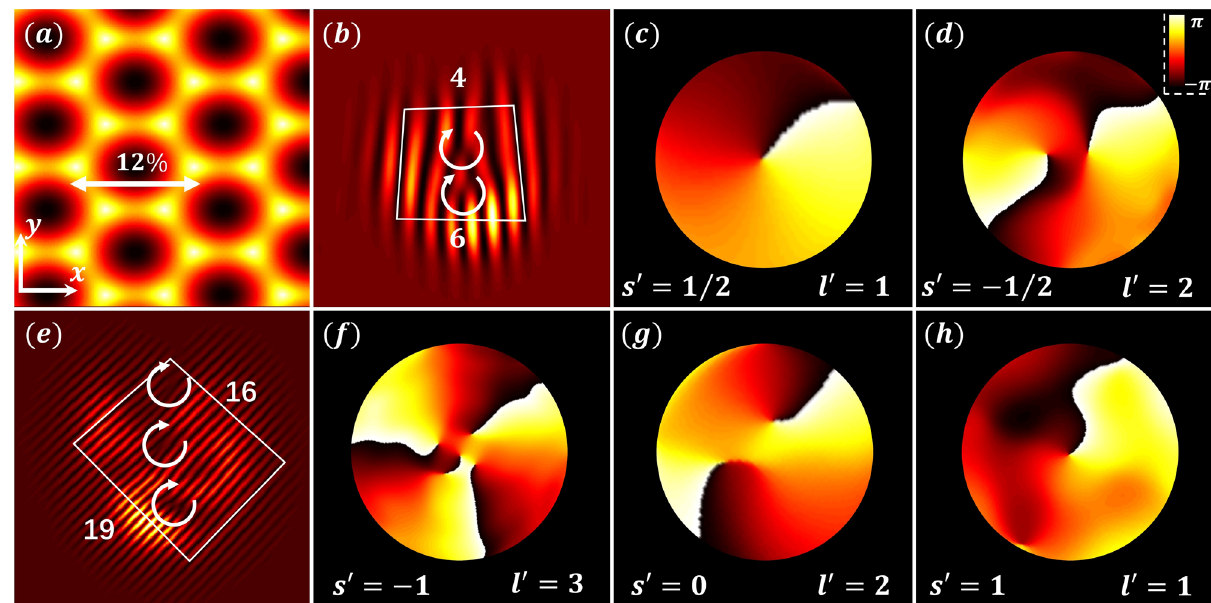
Fig. 6 Evolution of pseudospin states in stretched lattices lacking rotational symmetry around conical intersections. Top (bottom) row corresponds to a stretched HCL (Lieb lattice), with an initial excitation l = 1, s = 1/2 ( l = 1, s = 1). a A 12% horizontally stretched HCL. b , e Interferograms of the output beam, which clearly indicate the topological conversion from l to l + 2s (or l ± w ), corresponding to results from unstretched lattices of the top rows in Figs. 3b and 5b. This is underpinned by the phase structure of the pseudospin components at the output illustrated in ( c , d ) and ( f – h ) for the two